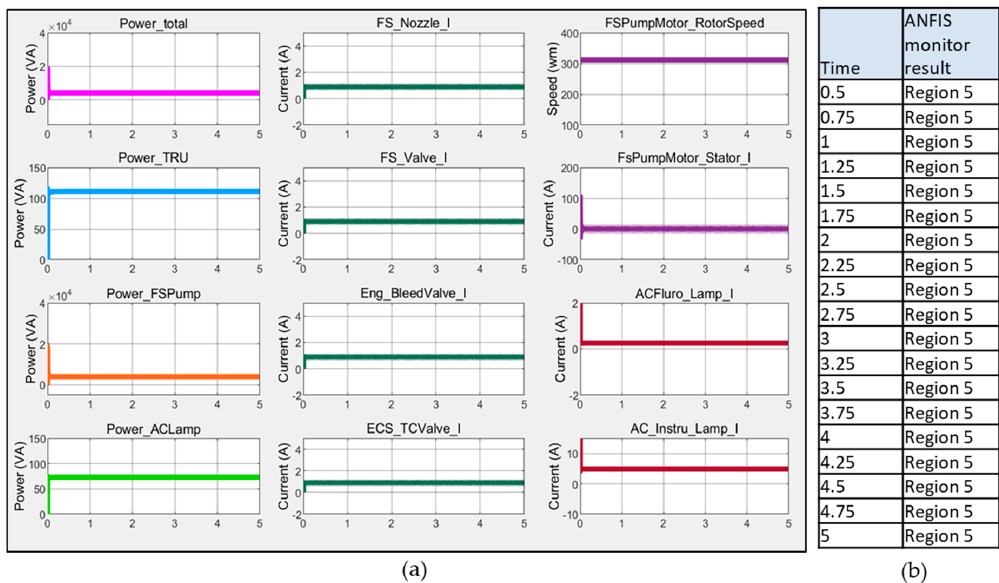
Figure 9. Healthy scenario using the crisp boundary approach. ( a ) EPS performance in terms of apparent power (left column), DC currents (middle column), [ump performance (top two plots in the right column), AC lamps current (bottom two plots in the right column). ( b ) The corresponding results generated by ANFIS monitor using Method 1 approach.